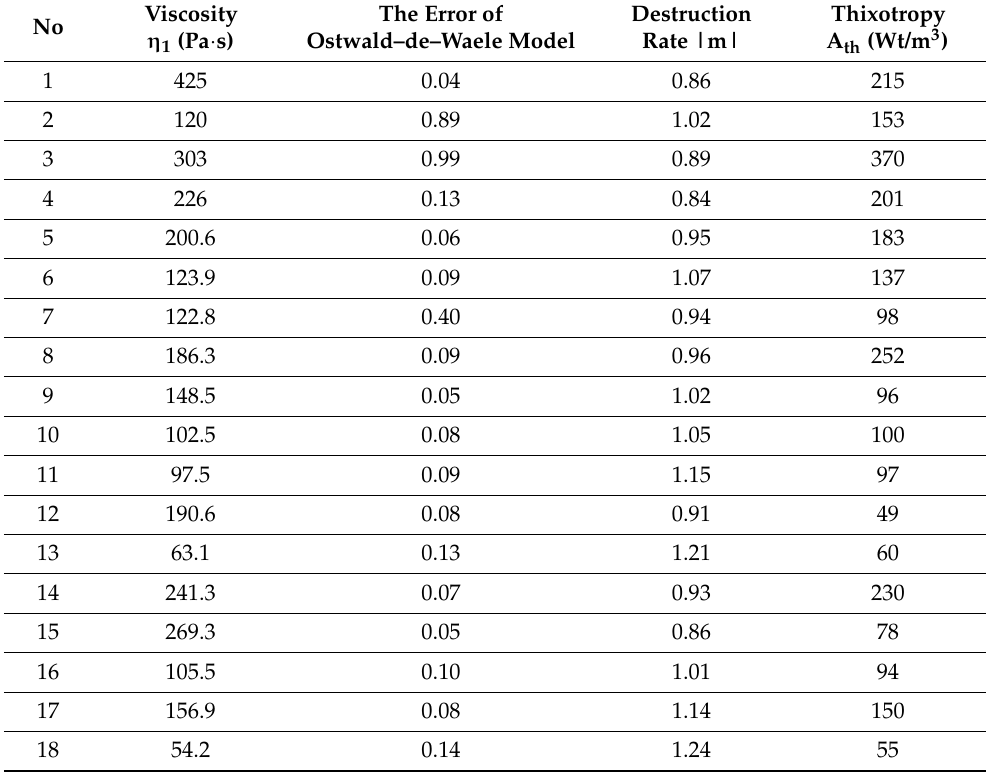
Table 3. The obtained values of rheological characteristics of the polymer–cementitious compositions.